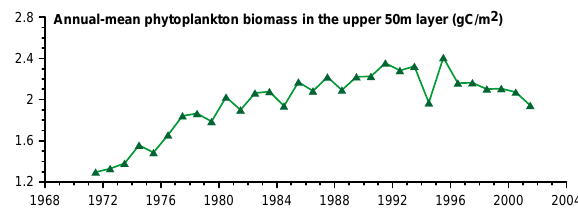
Figure 20 Evolution of the annual-mean phytoplankton biomass in the upper 50m layer for the deep part of the Black Sea basin.